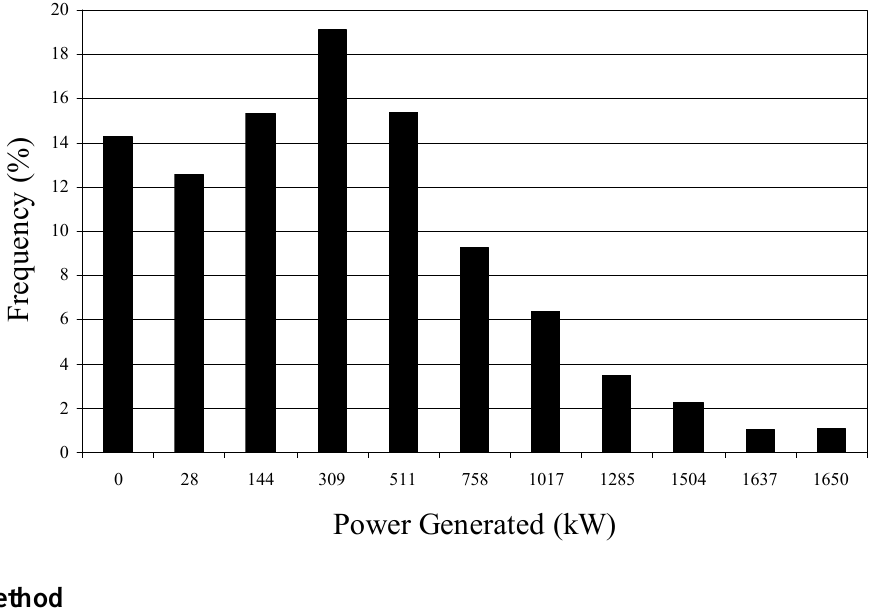
Figure 3. The expected frequency of power generation. Notice that the turbine is expected to not be producing power about 14% of the time, 1650 kW about one percent of the time, and 300 kW about 19% of the